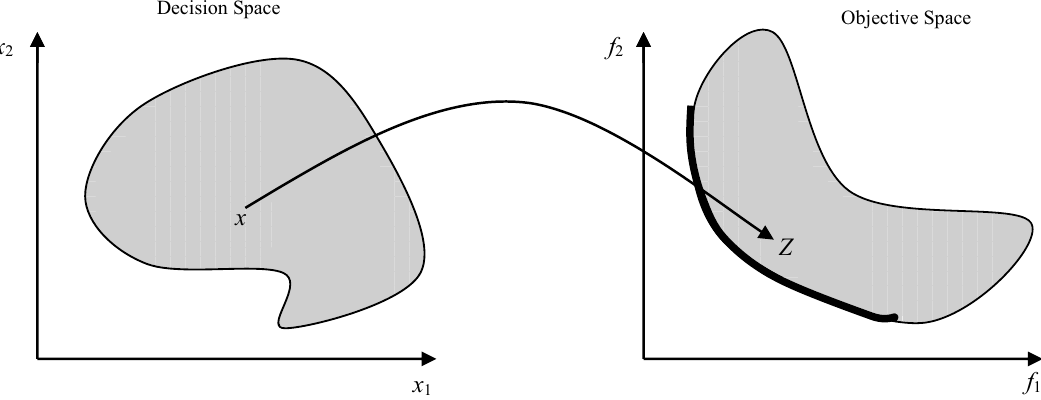
Fig. 4. Demonstration of the decision variable space and its corresponding